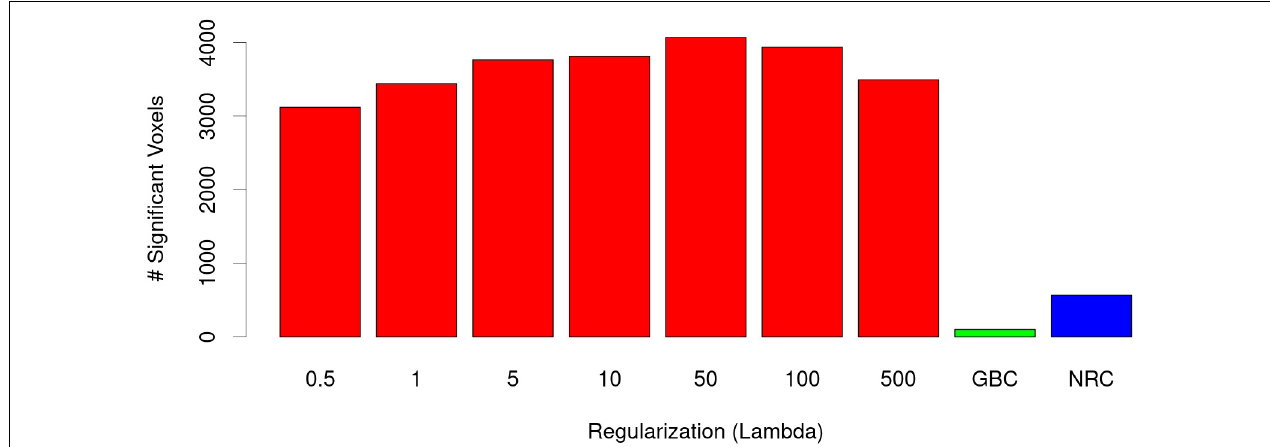
FIGURE 2 | Number of voxels with significant reductions in RBC connectivity in patients as a function of λ (red bars). Most extensive abnormalities were observed with λ = 50. In all cases these were much larger than reductions observed with the GBC (green) and the NRC